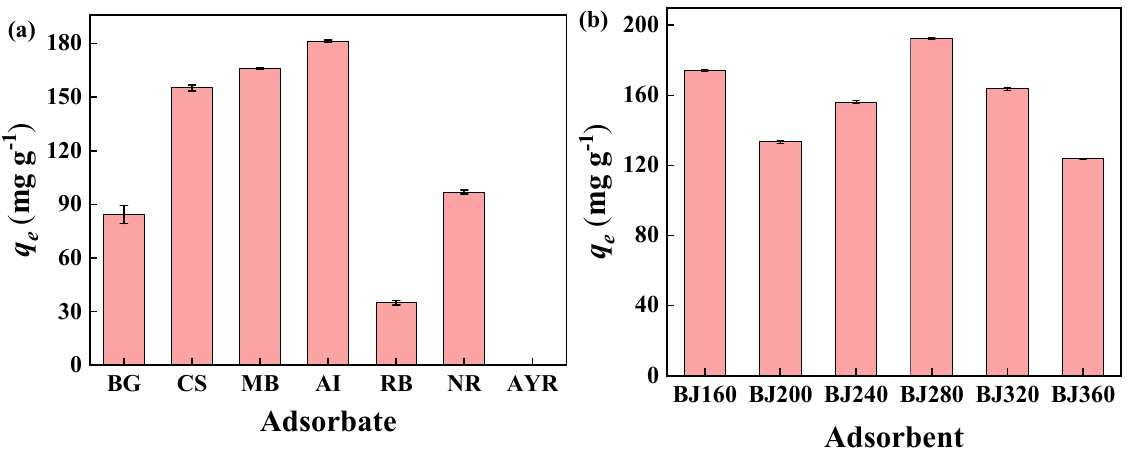
Figure 4. Adsorption performances of PoBJ biochar: ( a ) adsorption capacities of BJ160 toward different dyes in aqueous solutions (dye concentration = 50 mg L − 1 , adsorbent dosage = 5.0 mg, and contact time = 60 min, T = 25 °C); ( b ) adsorption of MB by various BCs (BJ160, BJ200, BJ240, BJ280, BJ320 and BJ360; MB concentration = 50 mg L − 1 , adsorbent dosage = 5.0 mg, and contact time = 120 min, T = 25 °C).